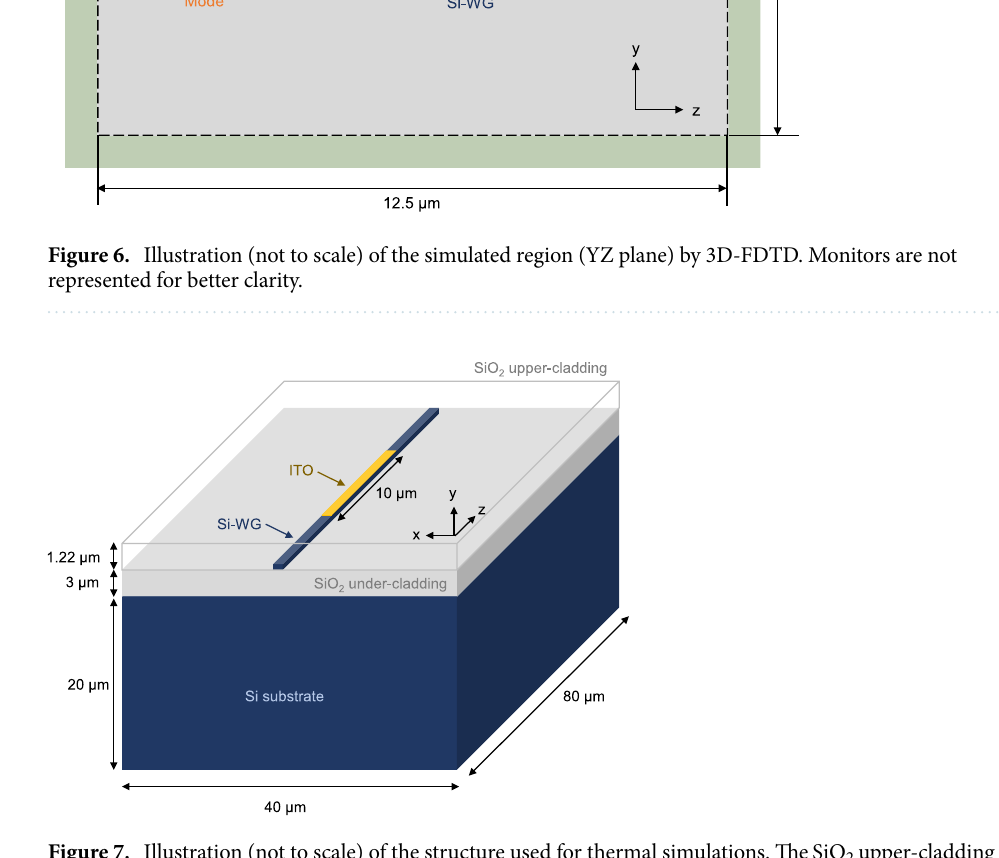
Figure 7. Illustration (not to scale) of the structure used for thermal simulations. The SiO 2 upper-cladding is set transparent for better clarity of the